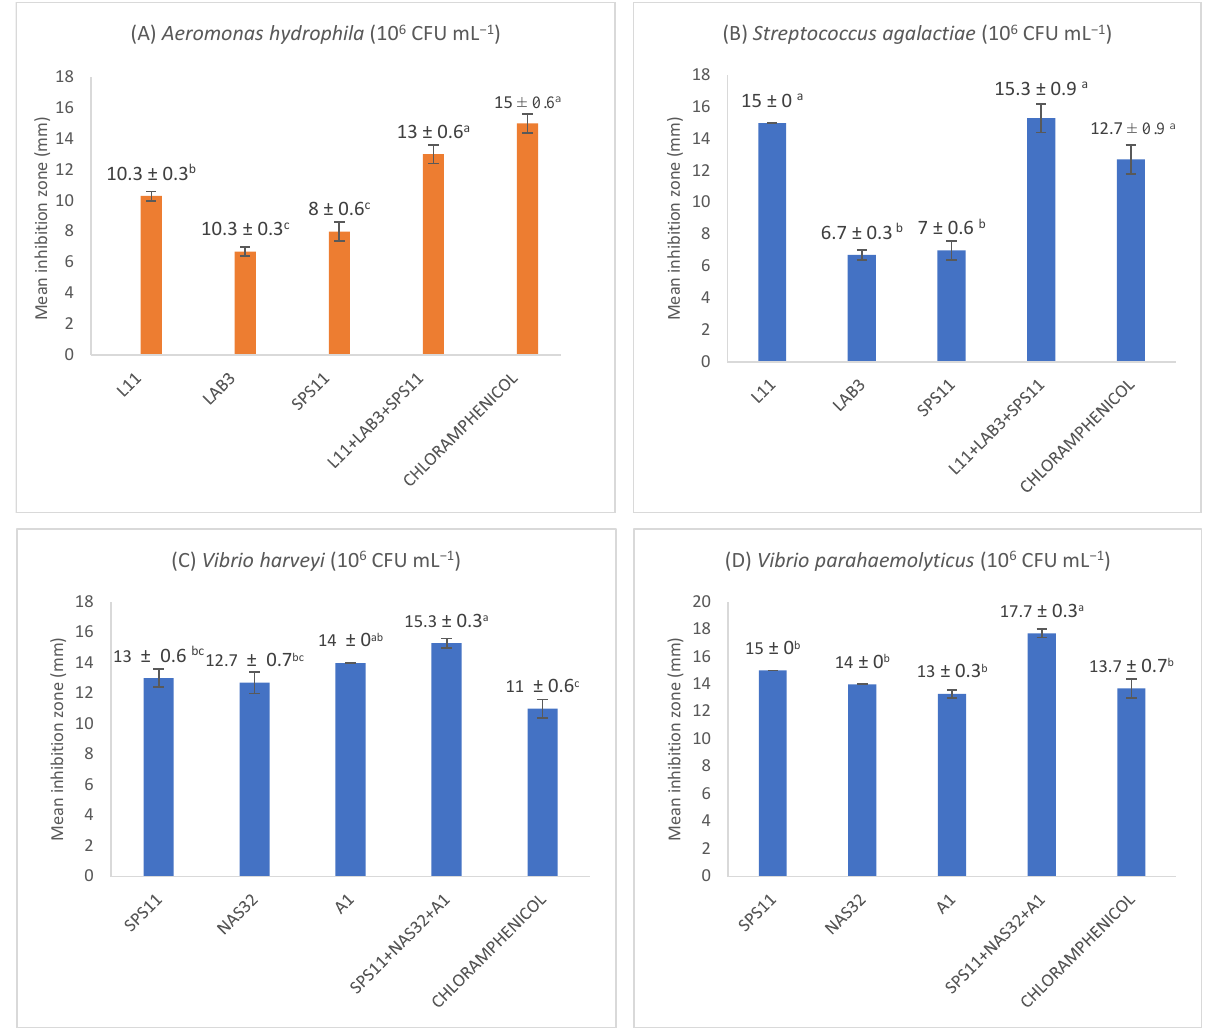
Figure 1. Agar well diffusion assay zone sizes for the inhibition of ( A ) Aeromonas hydrophila (10 6 CFU mL − 1 ), ( B ) Streptococcus agalactiae (10 6 CFU mL − 1 ), ( C ) Vibrio harveyi (10 6 CFU mL − 1 ), and ( D ) Vibrio parahaemolyticus (10 6 CFU mL − 1 ) using single- and multi-strain probiotics. L11 = Bacillus amyloliquefaciens ; LAB3 = Enterococcus hirae ; SPS11 = Lysinibacillus fusiformis ; NAS32 = Lysinibacillus sphaericus ; A1 = Lysinibacillus fusiformis ; MSP1 = L11 + LAB3 + SPS11; MSP2 = SPS11 + NAS32 + A1; Chloramphenicol = Positive control. The values shown are the size of the inhibition zone ± SE ( n = 3). Different alphabetical letters ( a, b, c, ab, bc ) indicate a statistically significant difference ( p < 0.05).